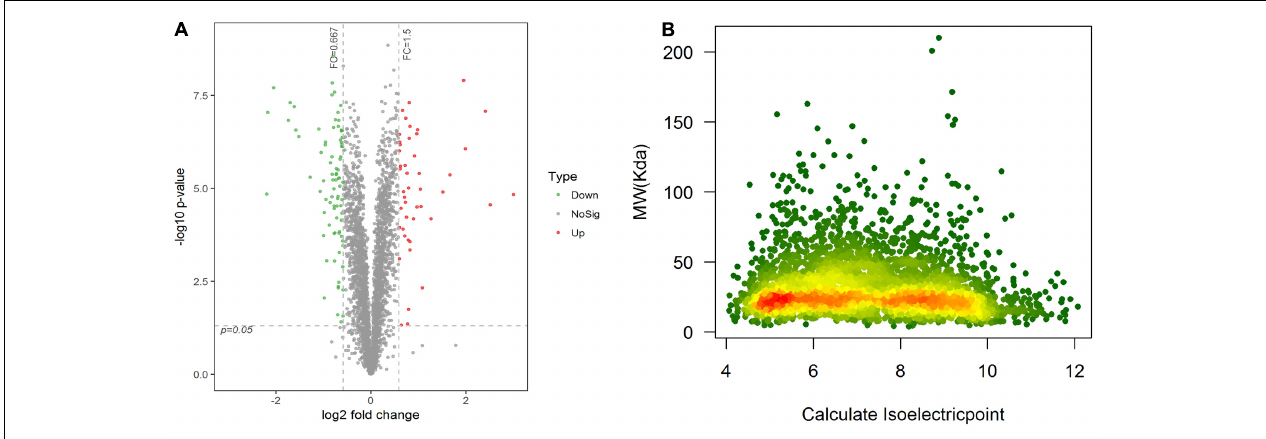
FIGURE 2 | (A) Ratio distribution of all quantitative proteins. Differentially expressed protein marked in red or green (red indicates upregulation and green indicates downregulation). (B) Theoretical 2-D (pI, MW) distribution of identified